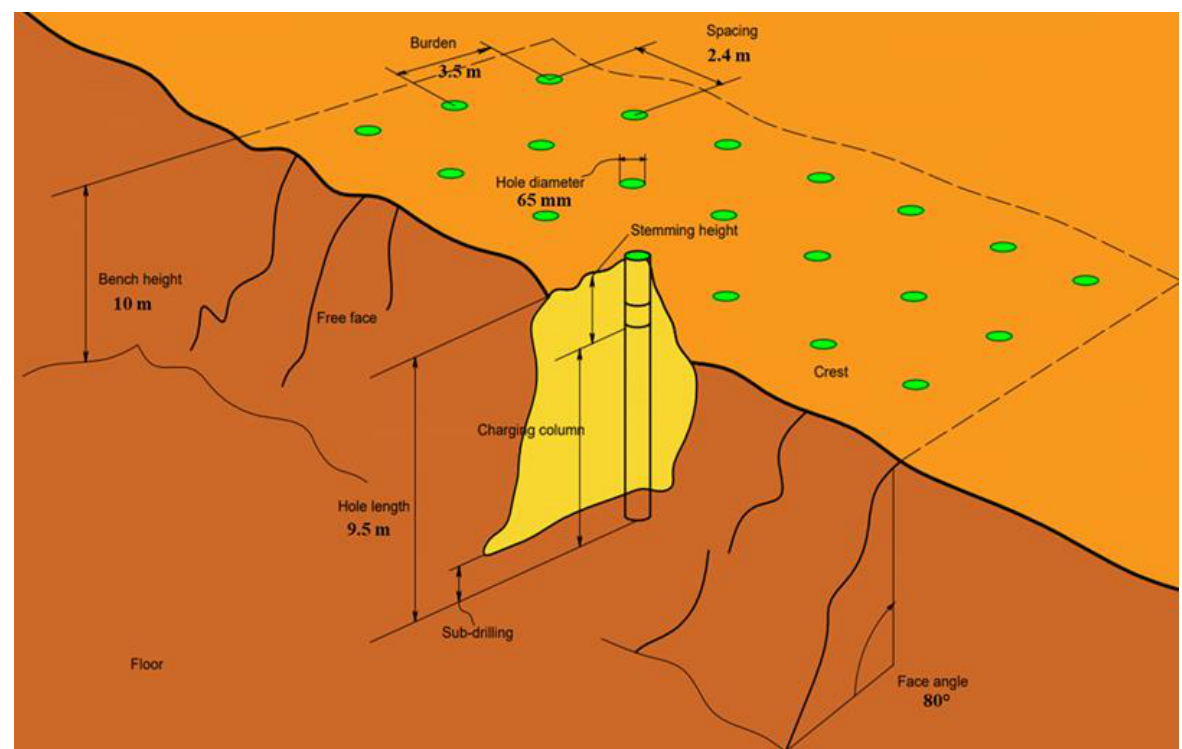
Figure 3. Blasting design of Mikurahana quarry site, with its blasting design parameters (i.e., bench height, stemming, face angle, burden, spacing, diameter of the hole, and charge column).